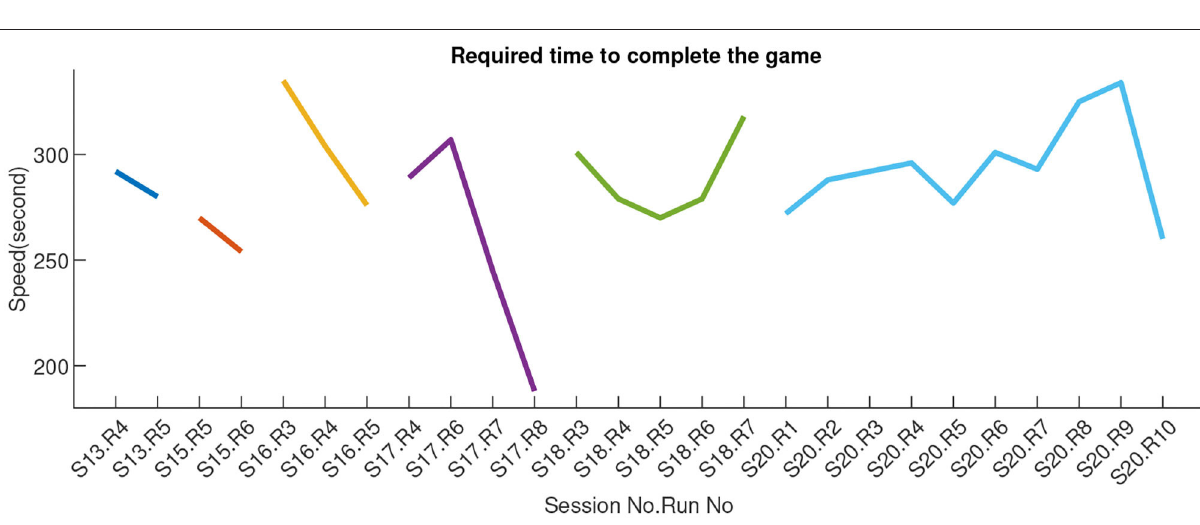
FIGURE 10 | Game performance in terms of required time for completing the race. Different colors represent different sessions. Session 19 game times were not